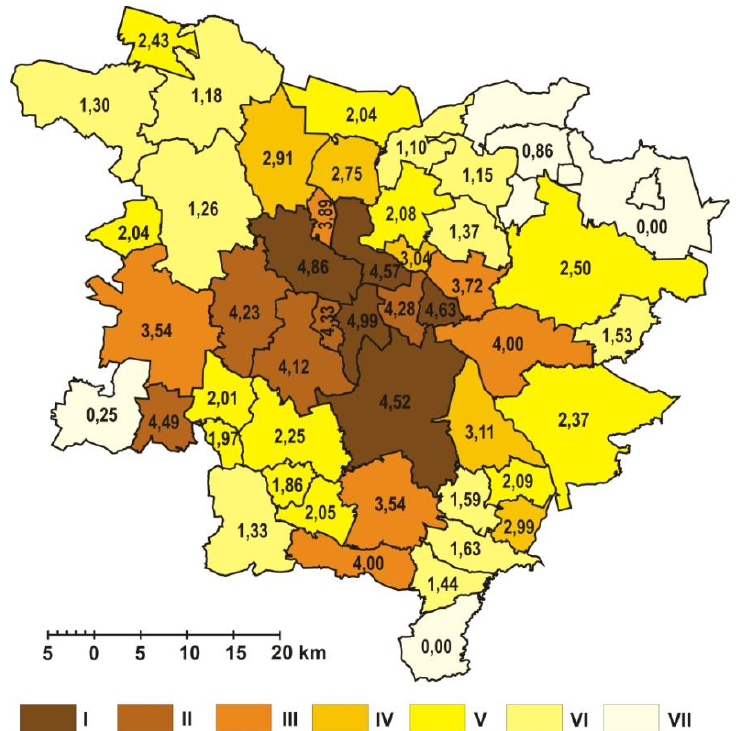
Fig. 2. Time accessibility of the community centres in the Katowice conurbation by Dcg index (own study) Values of Dcg index: I – 4.51 and more; II – 4.01 – 4.50; III – 3.26 – 4.00; VI – 2.51 – 3.25; V – 1.76 – 2.50; VI – 1.01 – 1.75; VII – 1.00 and